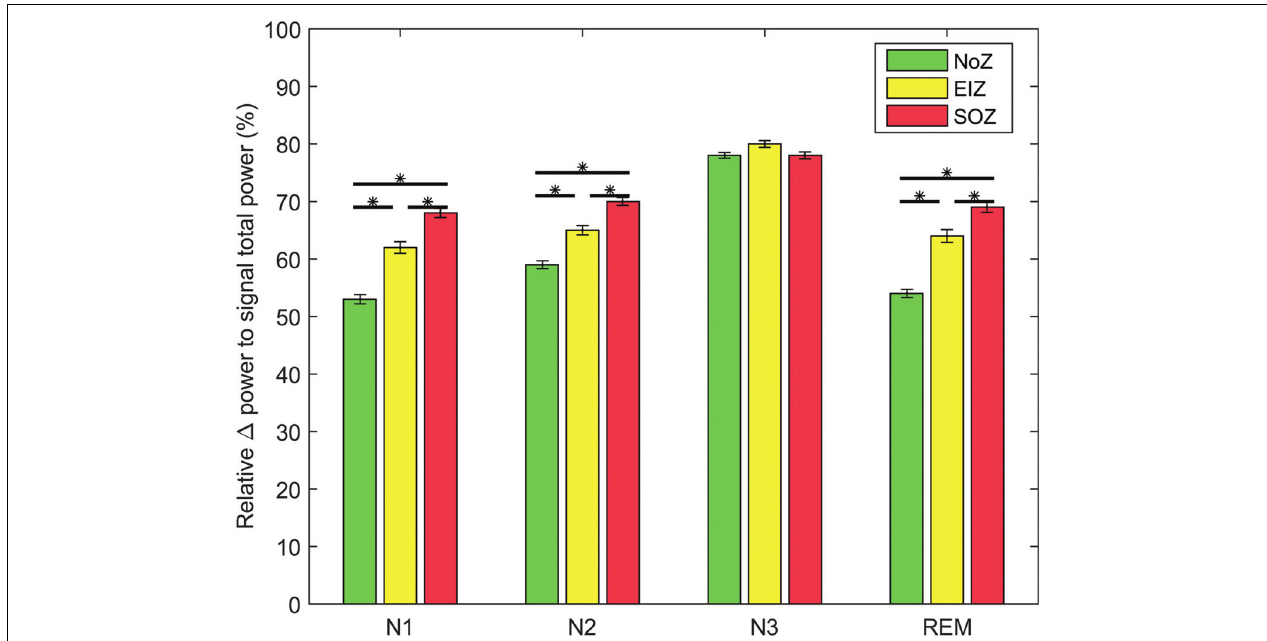
FIGURE 7 | Average of relative delta power in different regions; Green: NoZ, Yellow: EIZ, Red: SOZ. ∗ Shows significant difference ( p < 0.05, corrected). Results are plotted as the mean ±